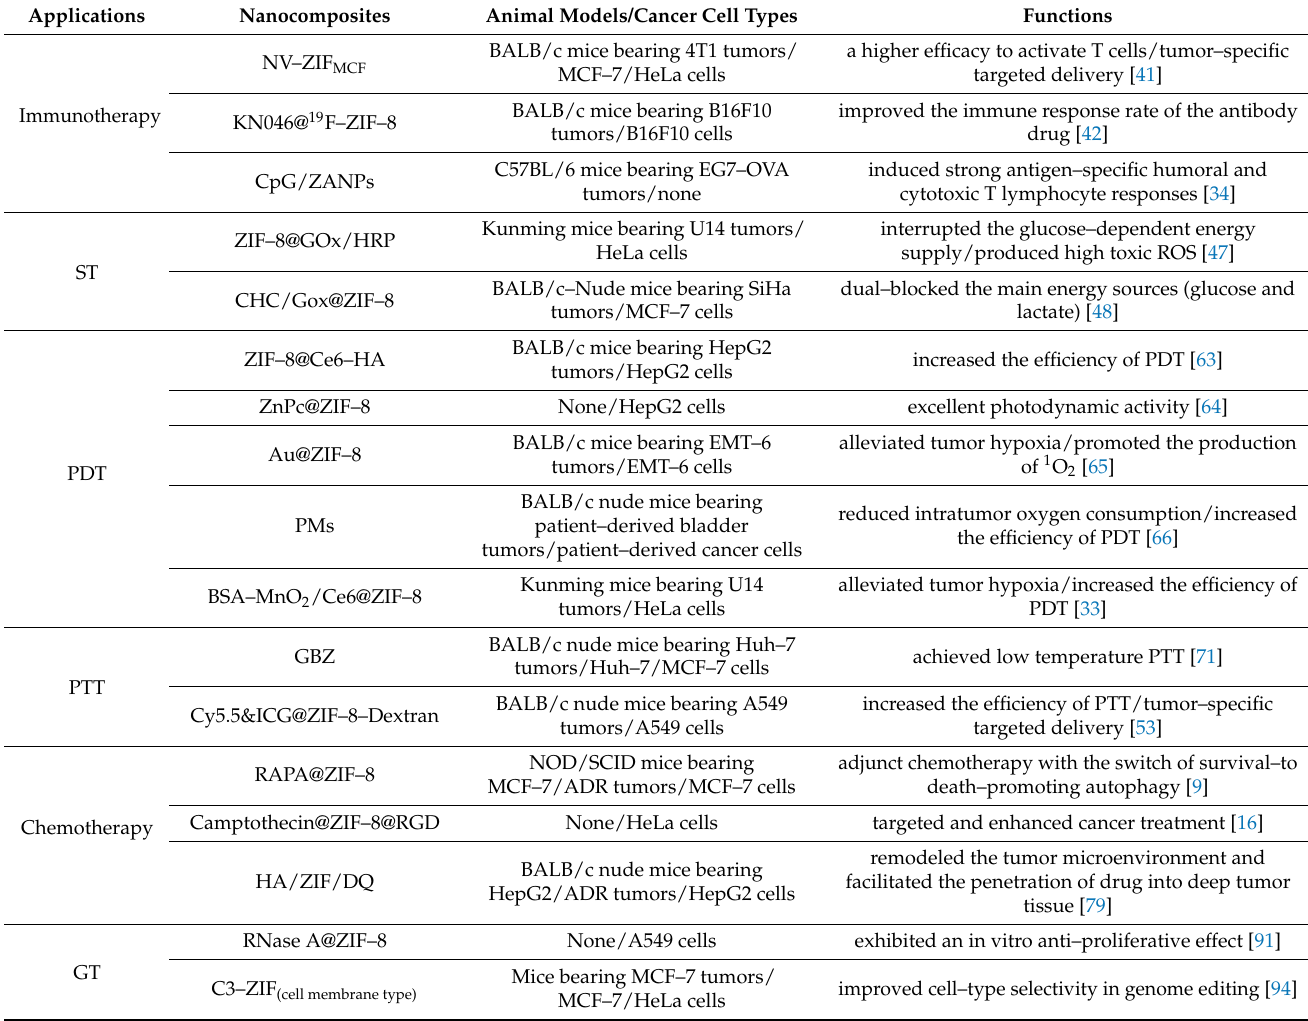
Table 2. Recent research on ZIF–8–based nanoplatforms for individual cancer